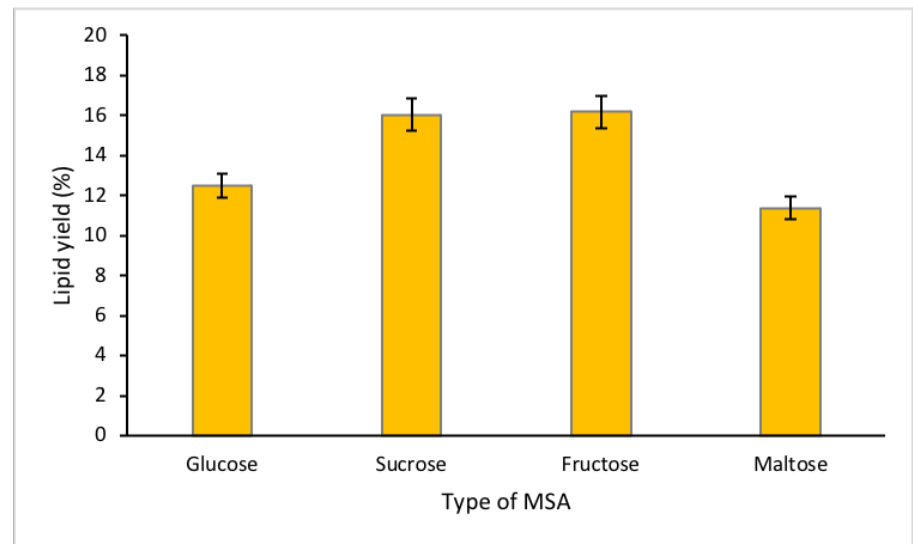
Figure 1. Percentage of lipid yield for different types of sugar.